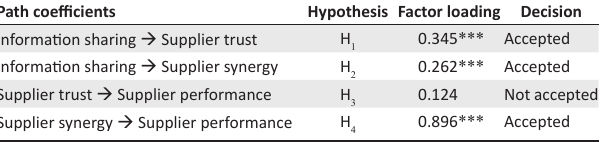
TABLE 3: Results of structural equation model